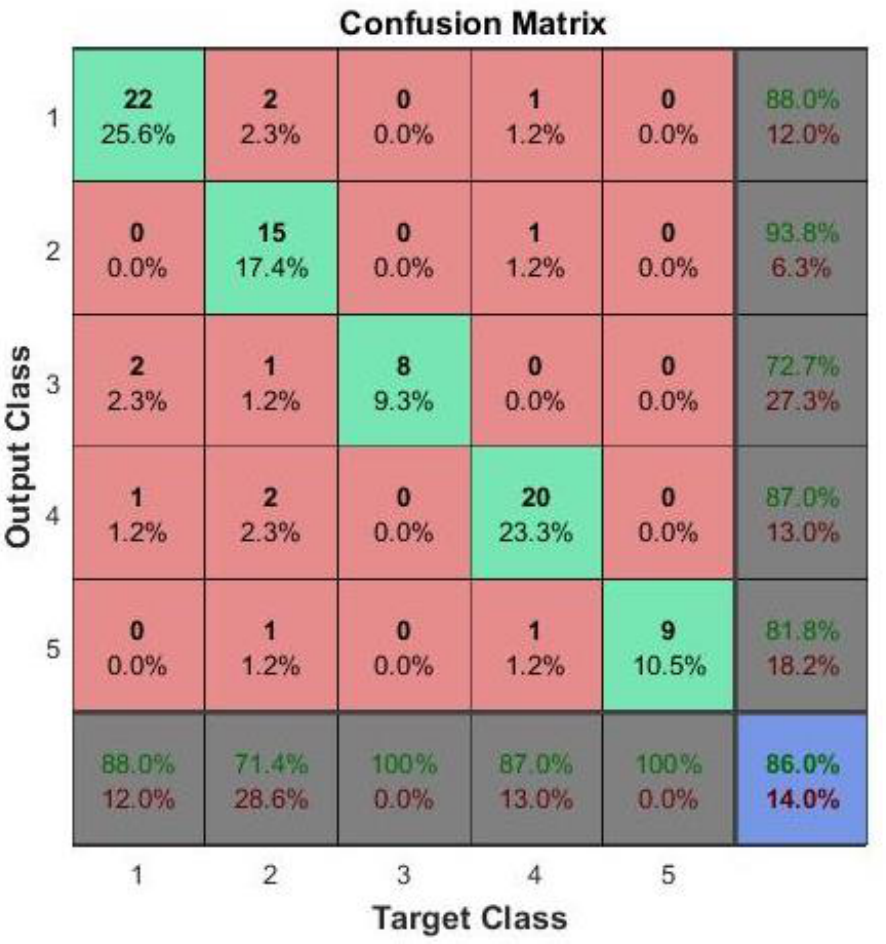
Figure 10. Confusion matrix for the grading details. The classes 1, 2, 3, 4 and 5 correspond to the grades 0, 0.5, 1, 2 and 3